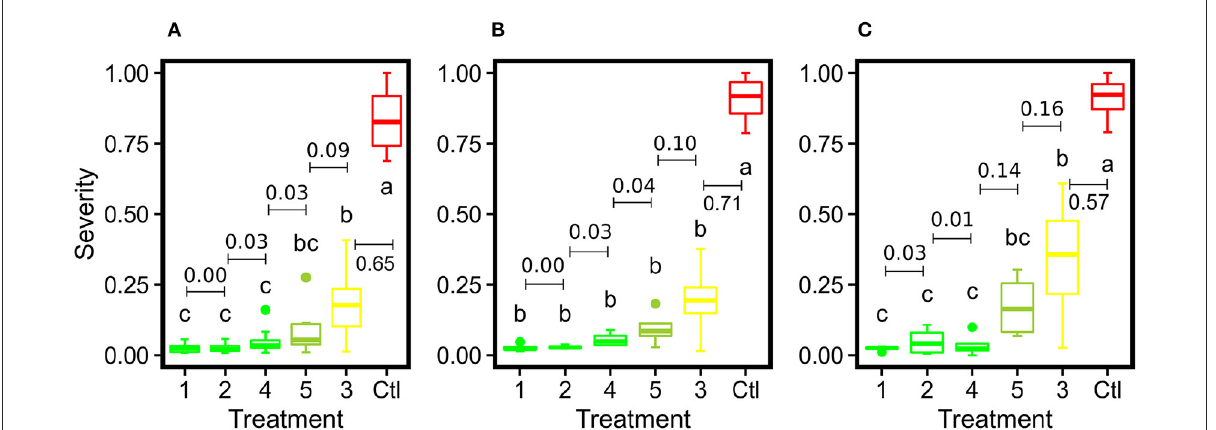
FIGURE9 Box plots of severity rates for the six treatments together with the control group for DM fungicide efficacy test in this study: (A) represents the imaging-derived severity rates at the panel level, (B) represents the imaging-derived severity rates at the spray unit level, and (C) represents the severity rates evaluated by human experts. Different letters indicate statistical significance between groups. Treatments within the same group are assigned the same color. The numbers with bars indicate differences of mean values between adjacent treatments.